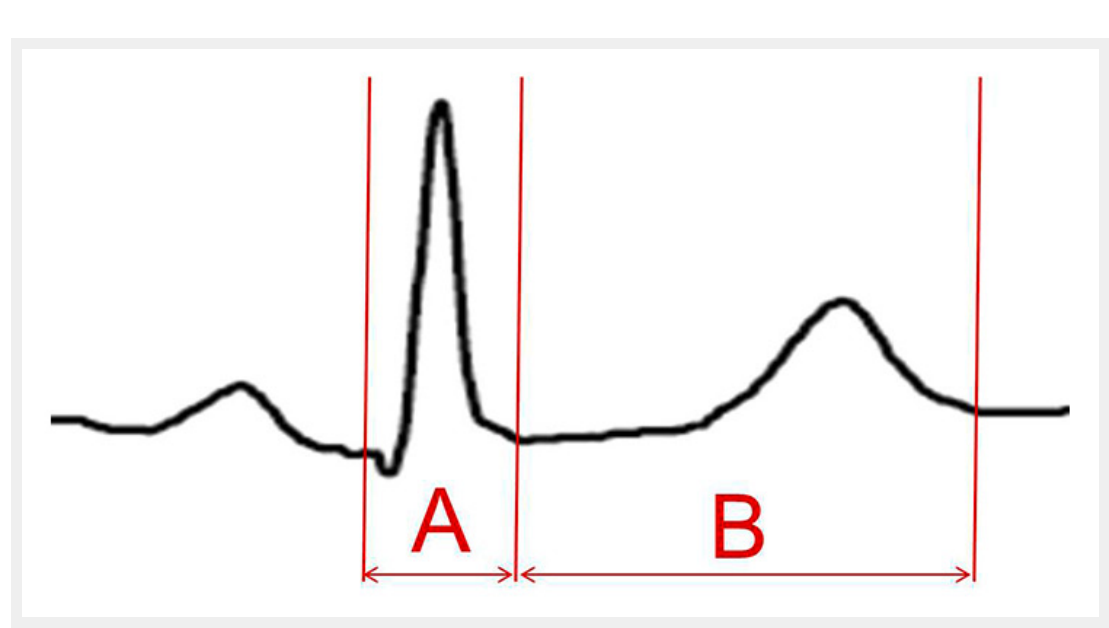
Figure 1 Normal sinus beat from lead II of a 12-lead ECG. Period (A) marks the ventricular depolarisation occurring during the QRS complex. Period (B) marks ventricular repolarisation consisting of the ST-segment and the